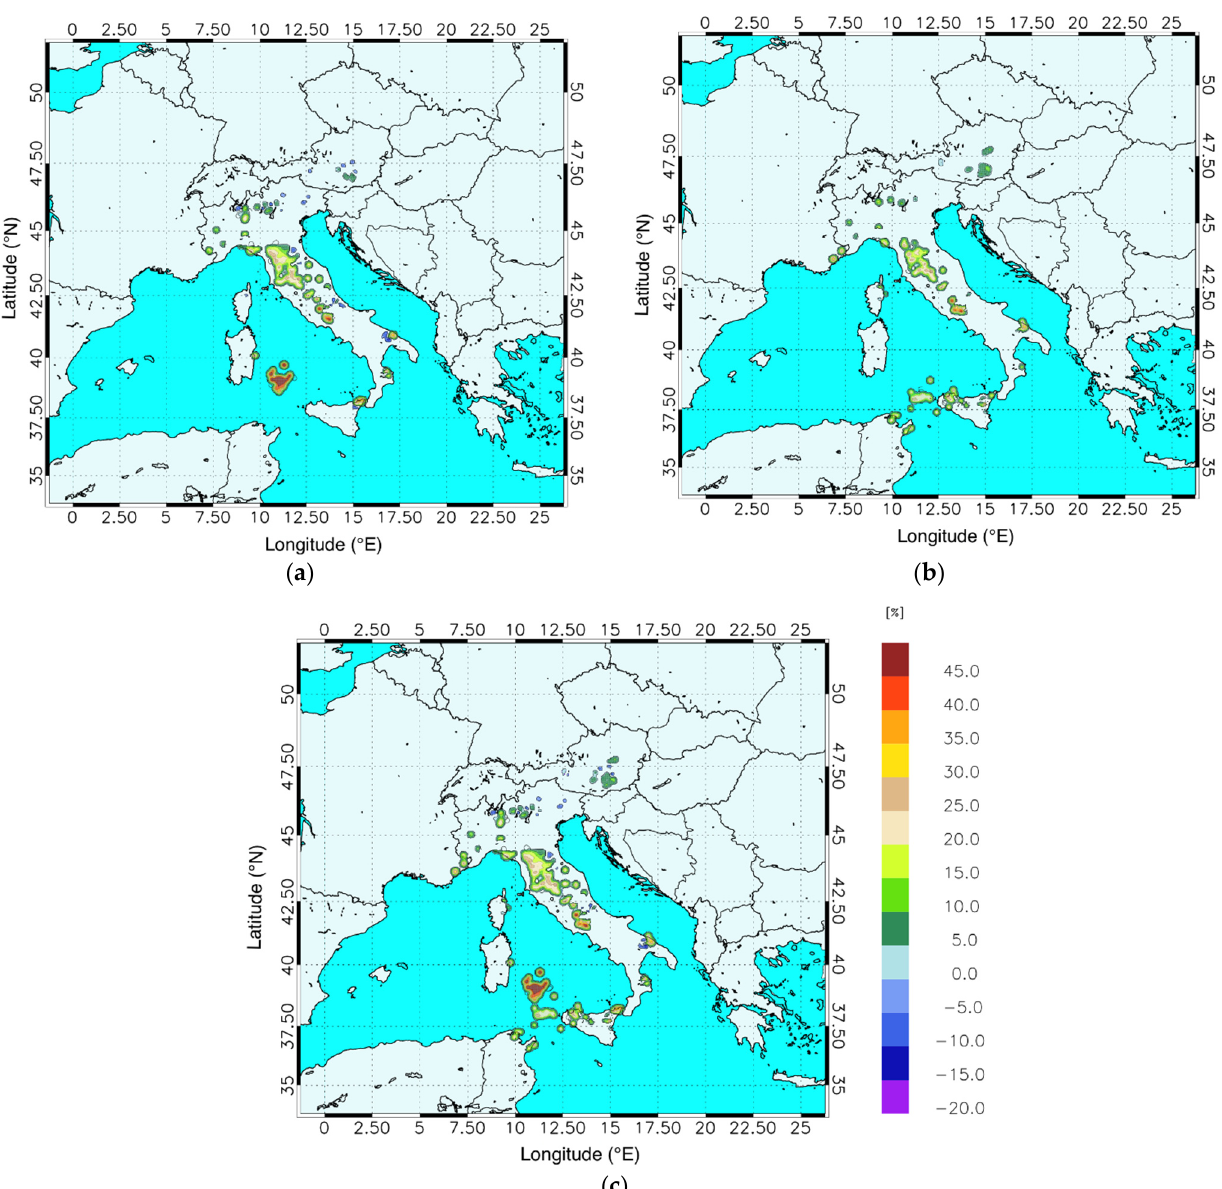
Figure 7. Analysis innovations for relative humidity at 13:30 UTC and at a height of 2896 m in the terrain following the coordinate system of RAMS@ISAC for: ( a ) radar reflectivity data assimilation; ( b ) lightning data assimilation; ( c ) radar reflectivity and lightning data assimilation.